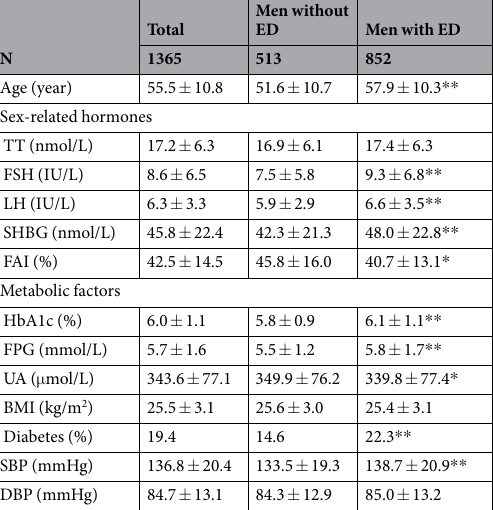
Table 1. General characteristics of the participants. The data are summarized as the mean ± standard deviation for continuous variables, or as number with proportion for categorical variables. The Mann–Whitney U test was used for non-normally distributed continuous variables, and the Pearson χ 2 test was used for dichotomous variables * P < 0.05, significantly lower than men without ED group. ** P < 0.05, significantly higher than men without ED group. Abbreviations: ED, erectile dysfunction; TT, total testosterone; FSH, follicle-stimulating hormone; LH, luteinizing hormone; SHBG, sex hormone binding globin; FAI, free androgen index; HbA1c,